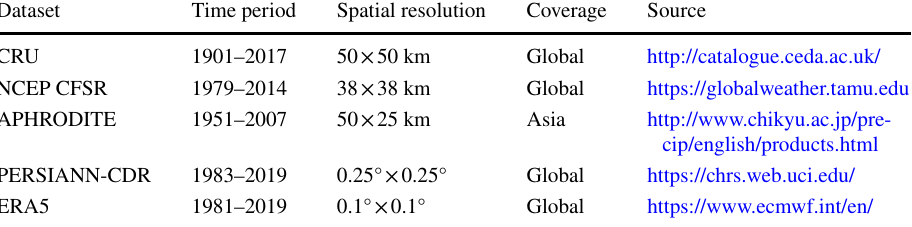
Table 2 The features of the five applied datasets in this